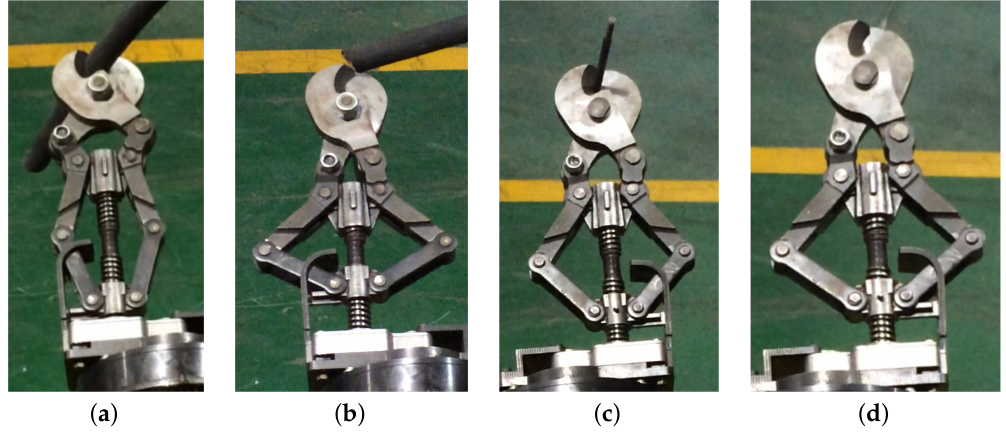
Figure 29. The cutting performance of the scissors joint assembly unit; ( a – b ) scissors cutting cable; ( c – d ) scissors cutting a steel roll bar.